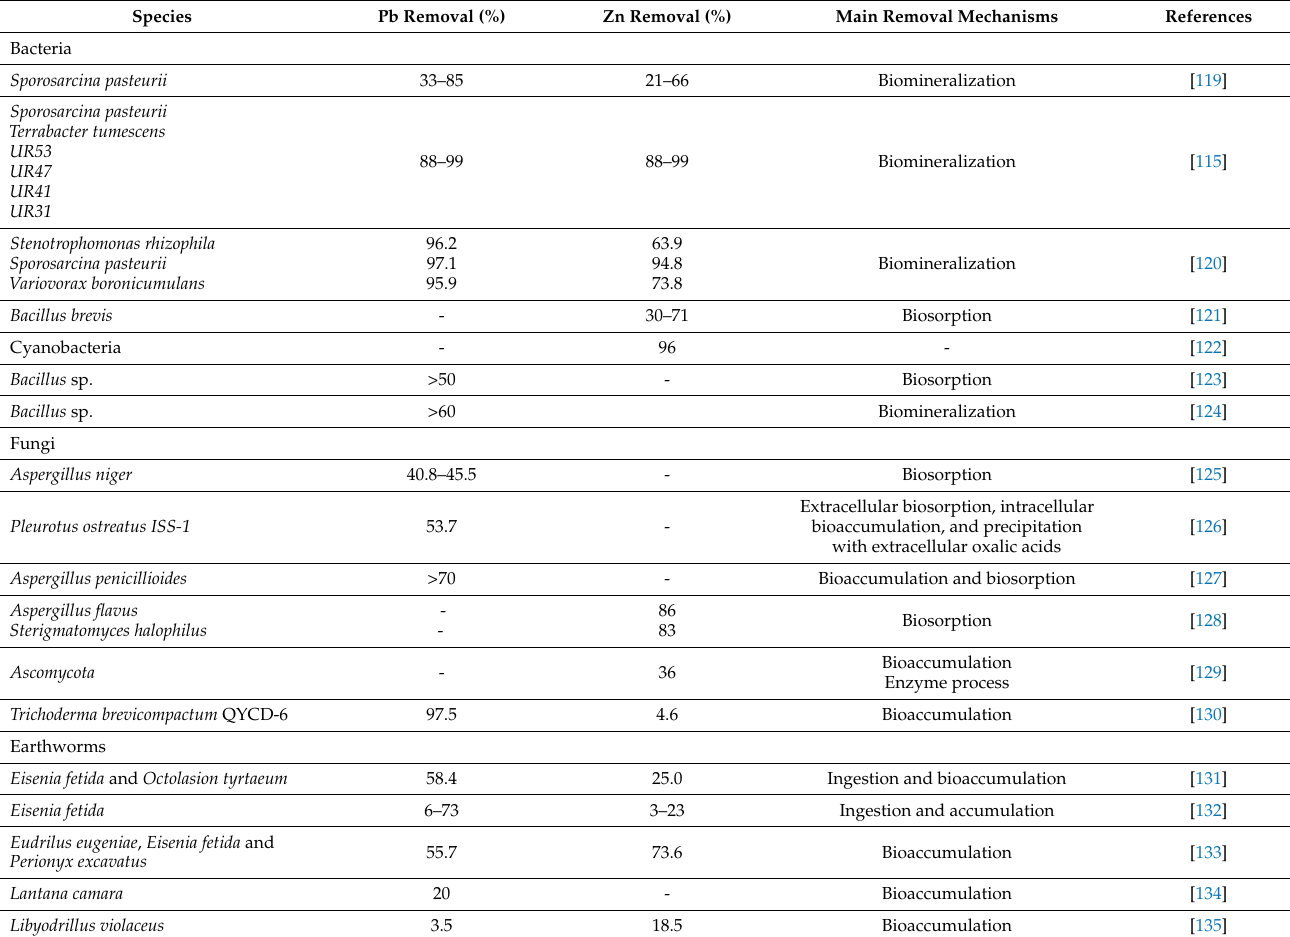
Table 3. Bacteria, fungi, and earthworms for removal of Zn and